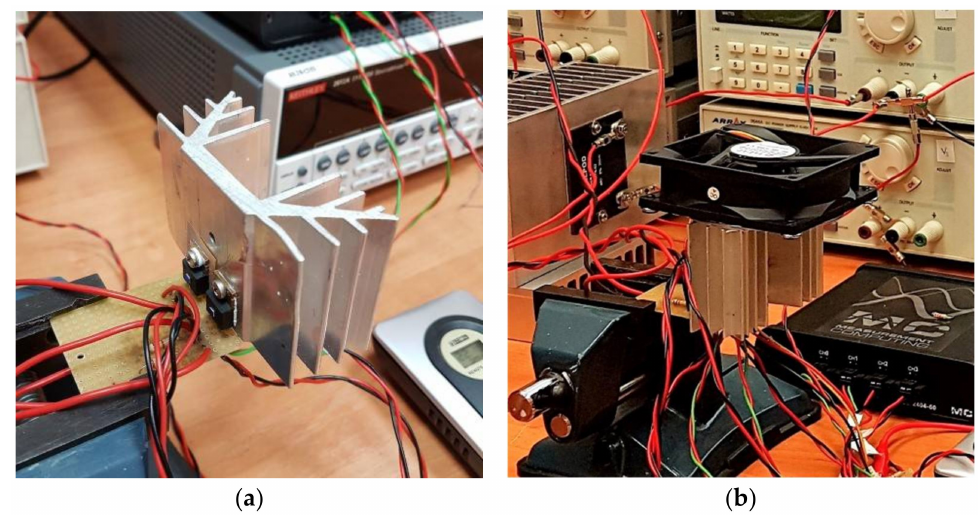
Figure 3. Cooling system ( a ) D and ( b )